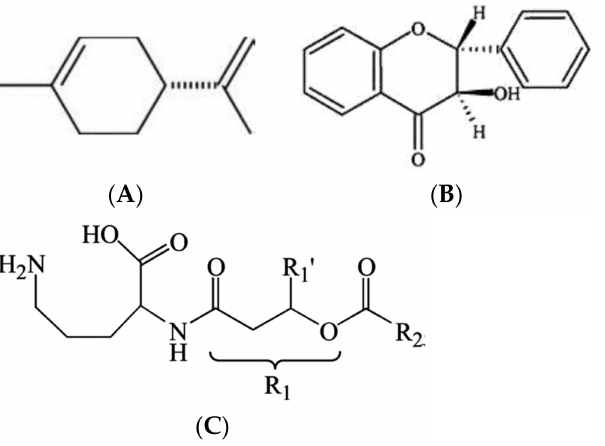
Figure 6. Secondary metabolites produced by B. gladioli pv. agaricicola . Where ( A ) D-Limonene, ( B ) 4-Flavanone, ( C ) Ornithine